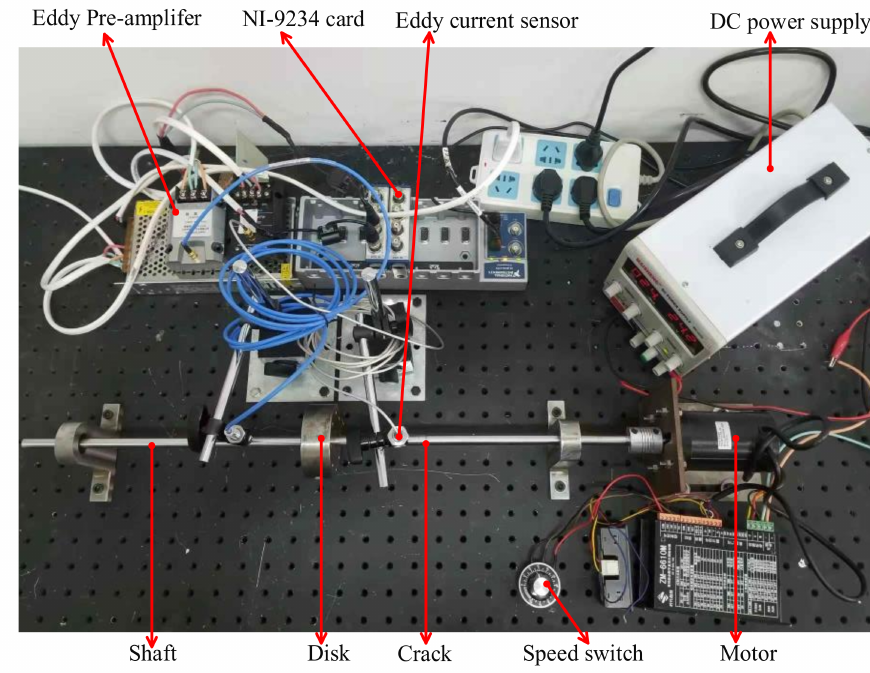
Figure 11. Experimental test bench of the cracked rotor system.